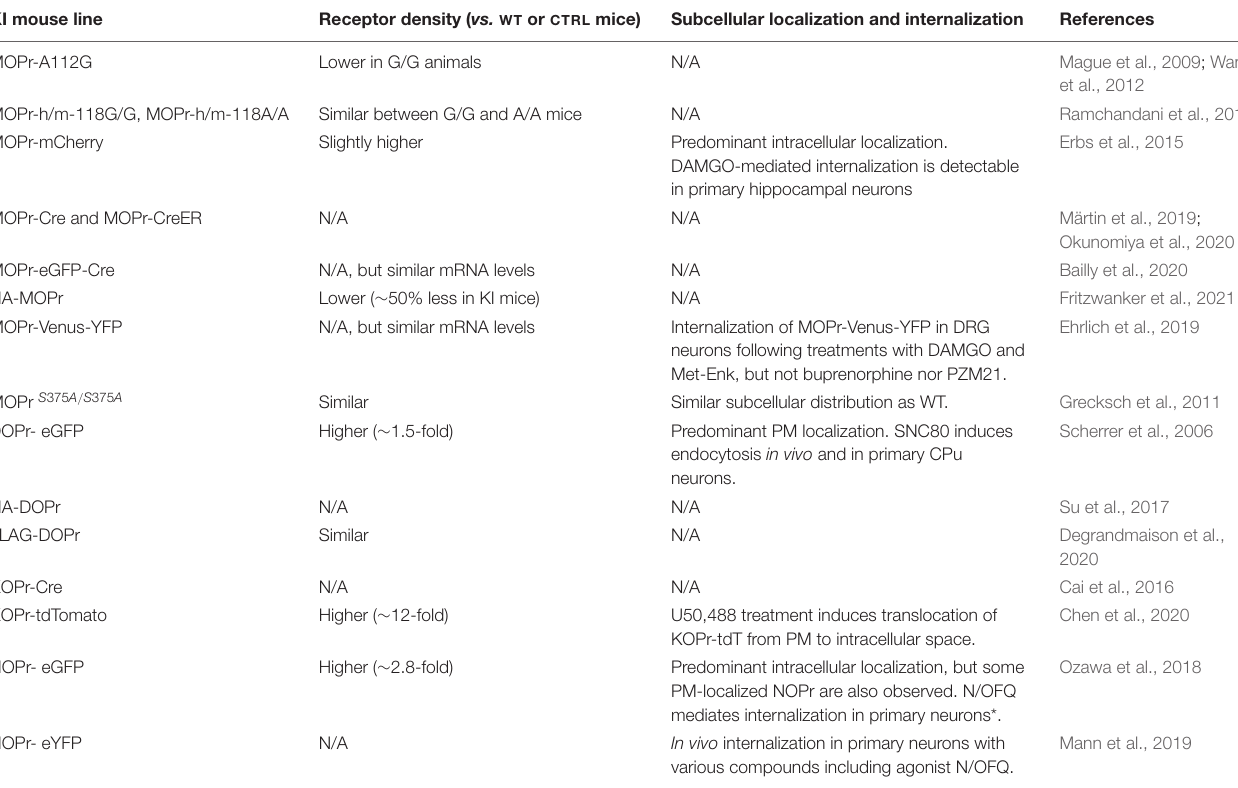
TABLE 1 | Characterization of the expression levels, subcellular localization and internalization of genetically modified opioid receptors from KI mice. KI mouse